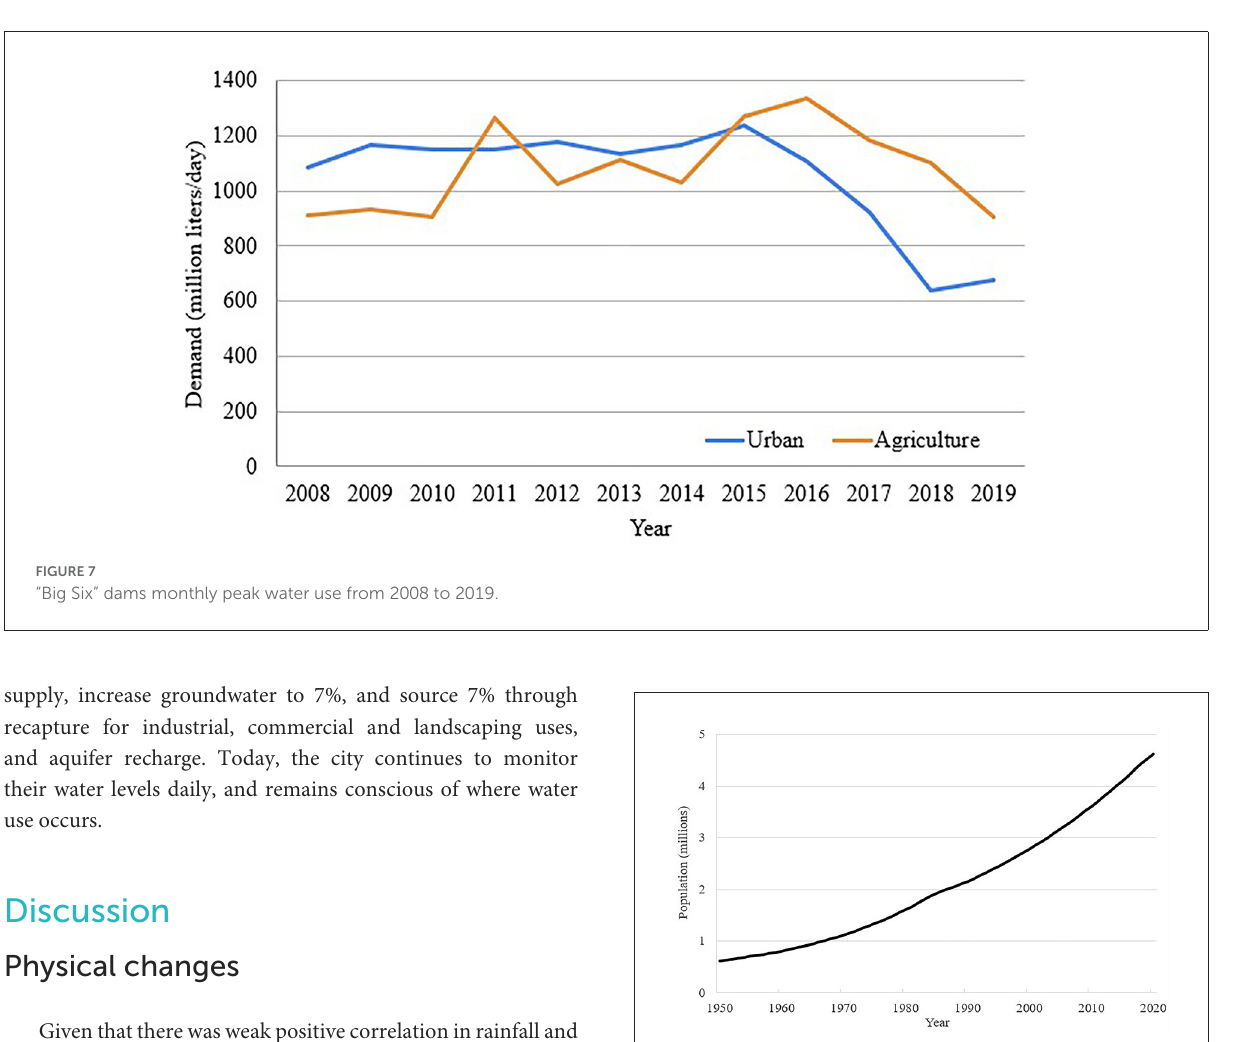
FIGURE8 Cape Town population from 1950 to